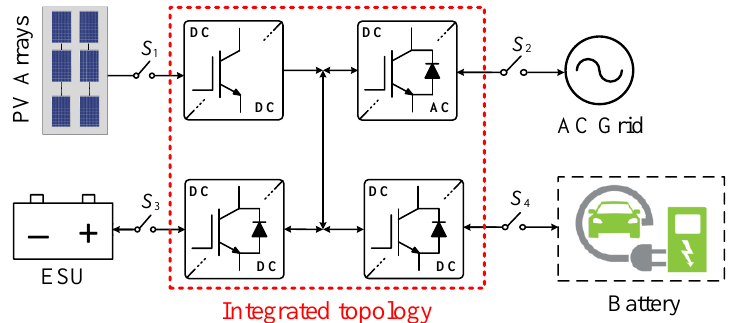
Figure 5. General architecture of integrated topologies for PV-grid EV chargers.